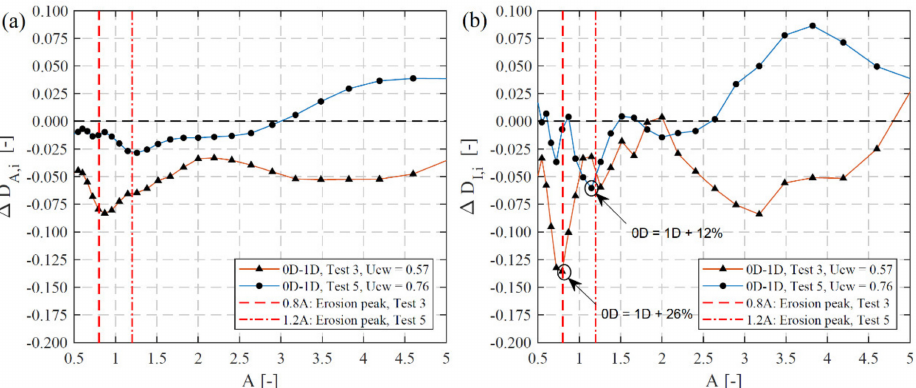
Figure 9. The cumulative ( D A , i ) ( a ) and incremental ( D I , i ) volume depth ( b ), calculated according Equations (4) and (5) of Tests 3 and 5, referring to 0D, are subtracted from values referring to tests conducted in a node distance of 1D. In this regard, a di ff erential erosion or deposition depth between 0D and 1D is calculated; positive values are referring to higher magnitudes of net erosion for 1D measurements, while negative values are revealing a higher net erosion for the present tests in a node distance of